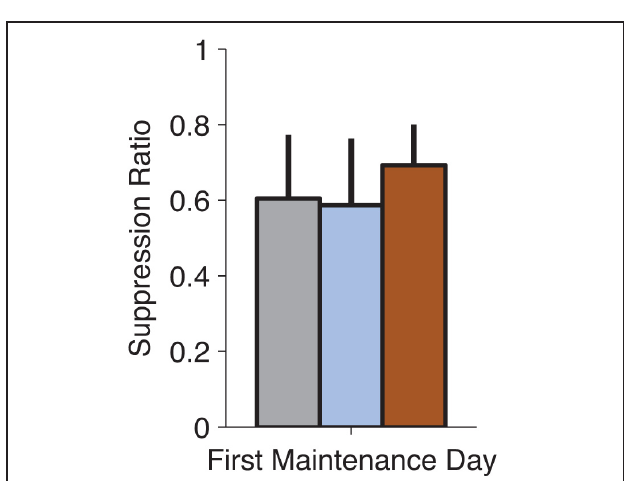
FIGURE 3 | Pentagastrin impairs recovery from fear. (A) Histogram of suppression ratio across trials for vehicle (gray), muscimol (blue), and pentagastrin (brown) sessions. The suppression ratio distribution is significantly bimodal for vehicle and pentagastrin (Hartigan’s Dip Test, p < 0 . 001 for both vehicle and pentagastrin) but not for muscimol (Dip Test, p > 0 . 7). In order to test recovery from fear we consider only the “high fear”